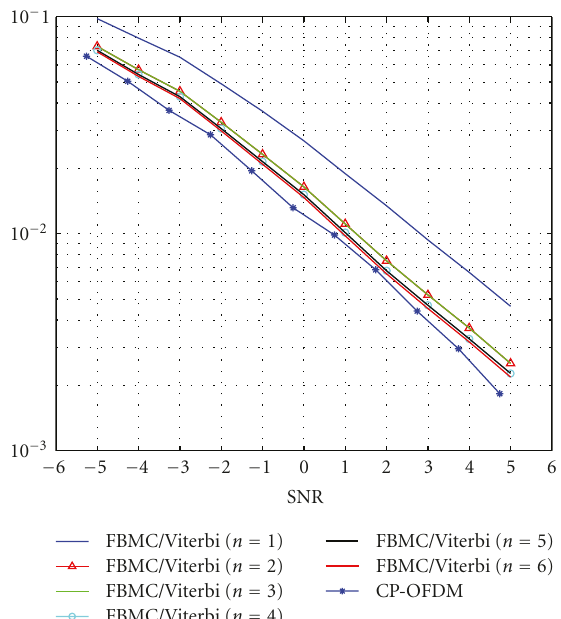
Figure 7: Performance of single delay STTC (iterative decoding) with 3 transmit antennas and one receive antenna (FBMC and CP- OFDM modulation).